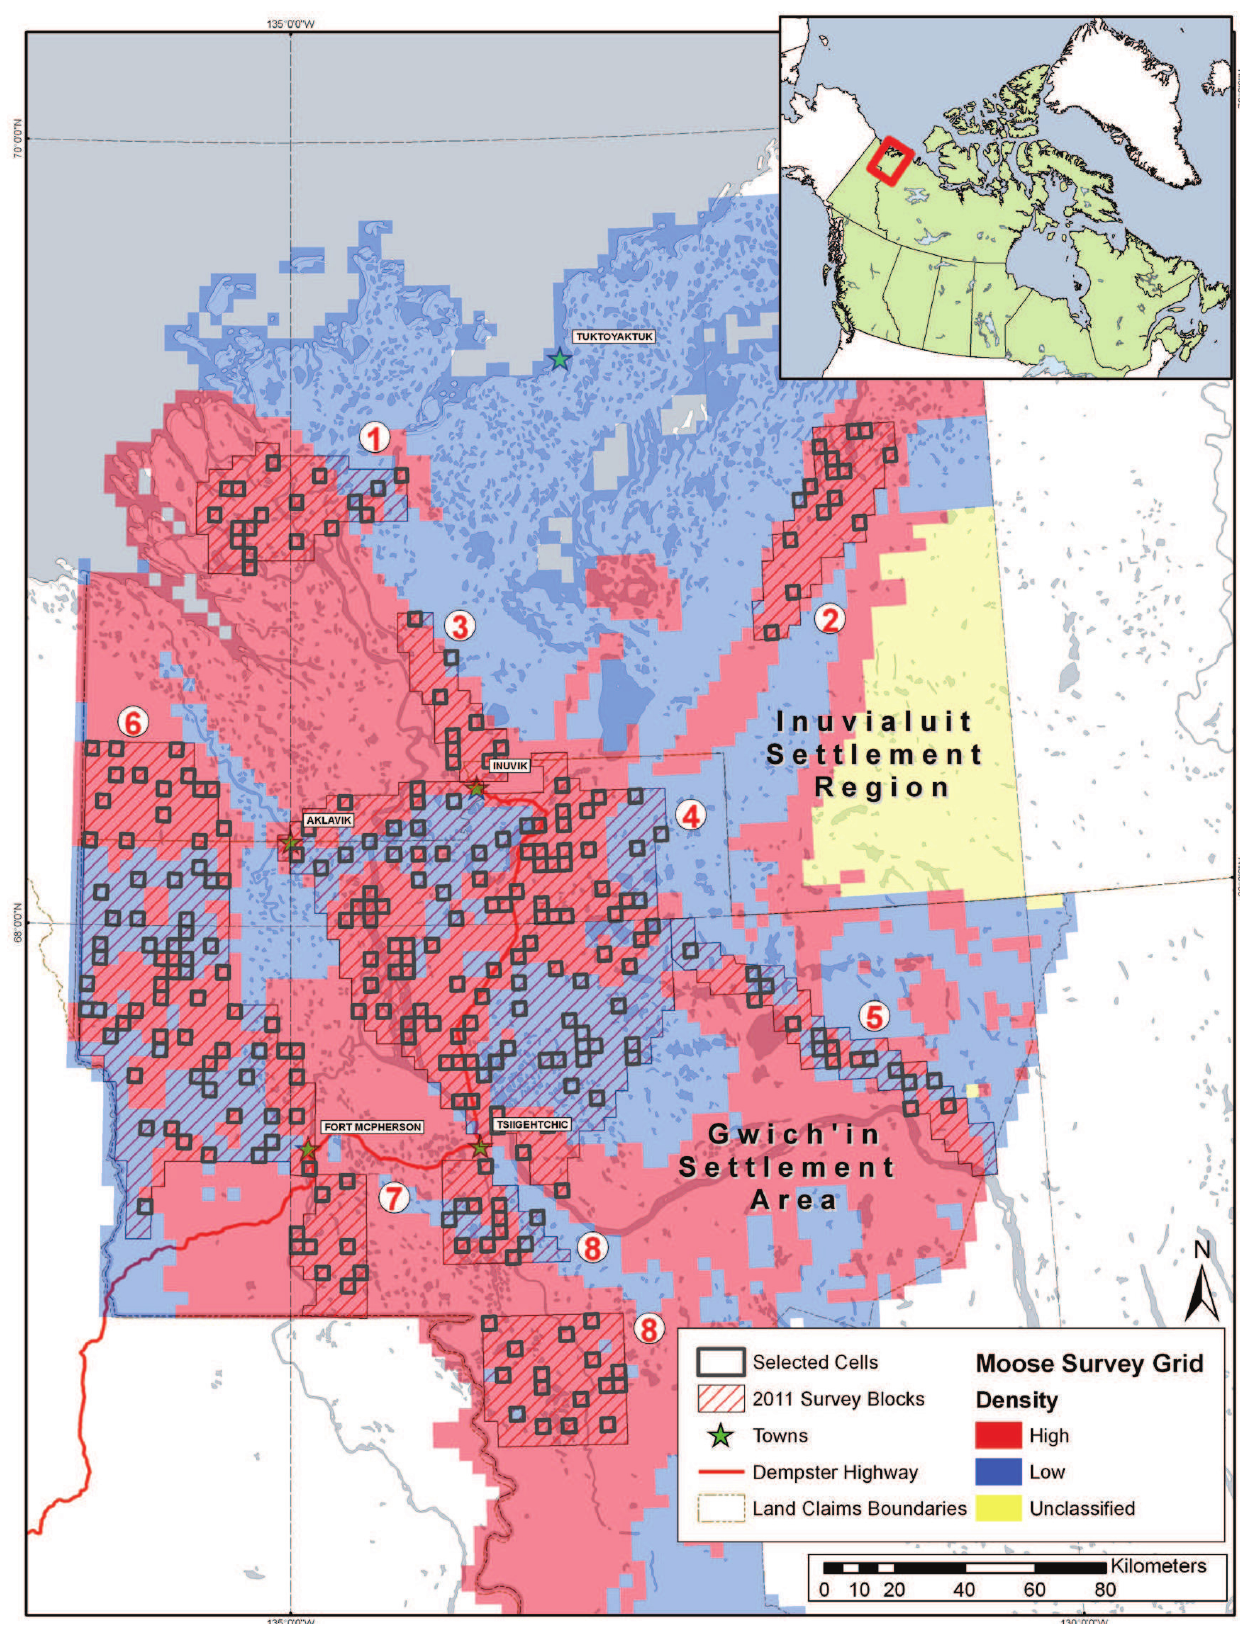
Fig. 1. Stratification and surveyed cells in eight survey blocks: 1) Delta North, 2) Kugaluk-Miner Rivers, 3) Ikhil Pipe- line, 4) Inuvik-Tsiigehtchic, 5) Mackenzie Gas pipeline route, 6) Richardson Mountains, 7) Peel River, and 8) Arctic Red